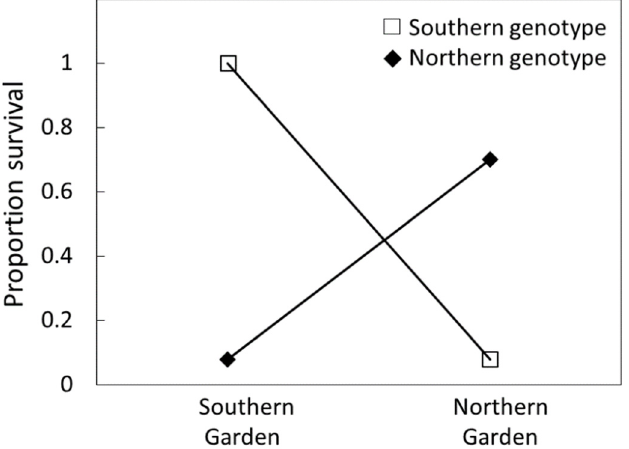
Figure 3. The proportion of original Cycas micronesica plants remaining alive over a 15 y growth period in two reciprocal garden locations in Guam. Open boxes represent southern Guam genotype, closed diamonds represent northern Guam genotypes.